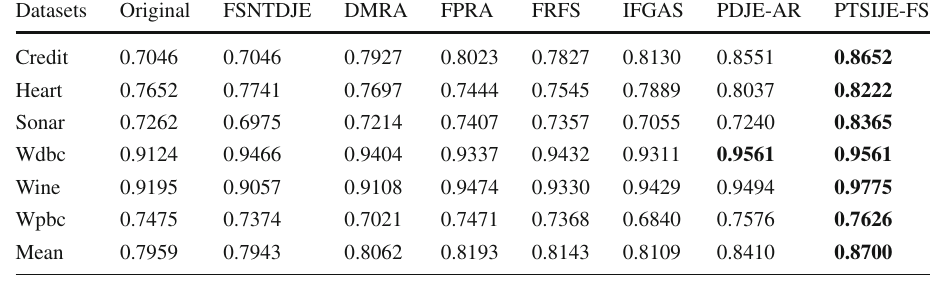
Table 6 Classification accuracy of the seven methods under the CART